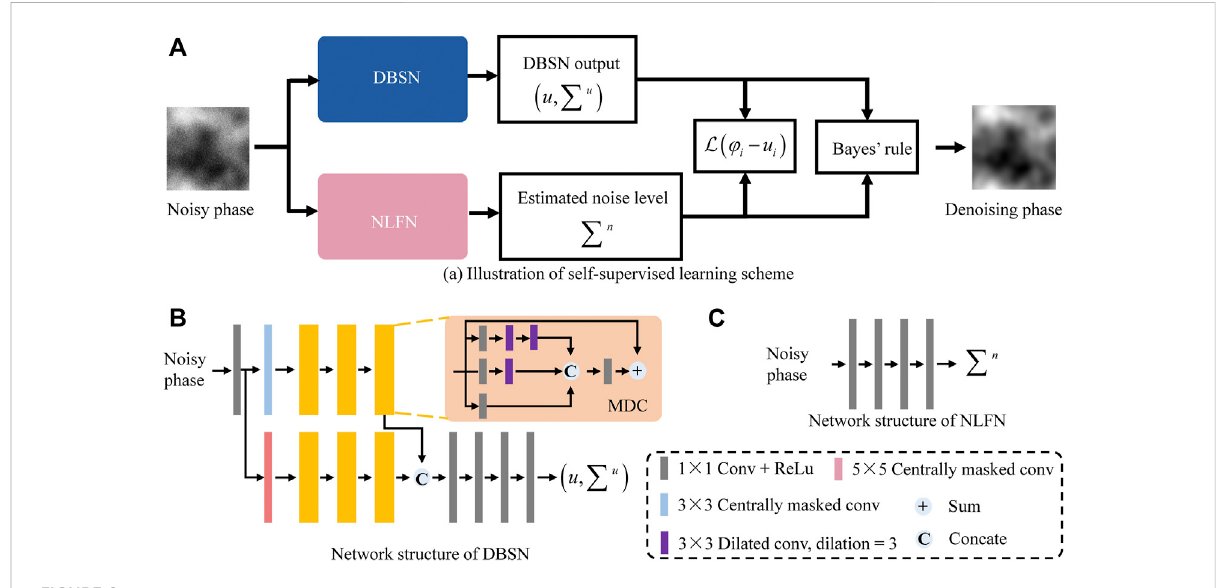
FIGURE 2 The framework for the label-free holographic phase noise